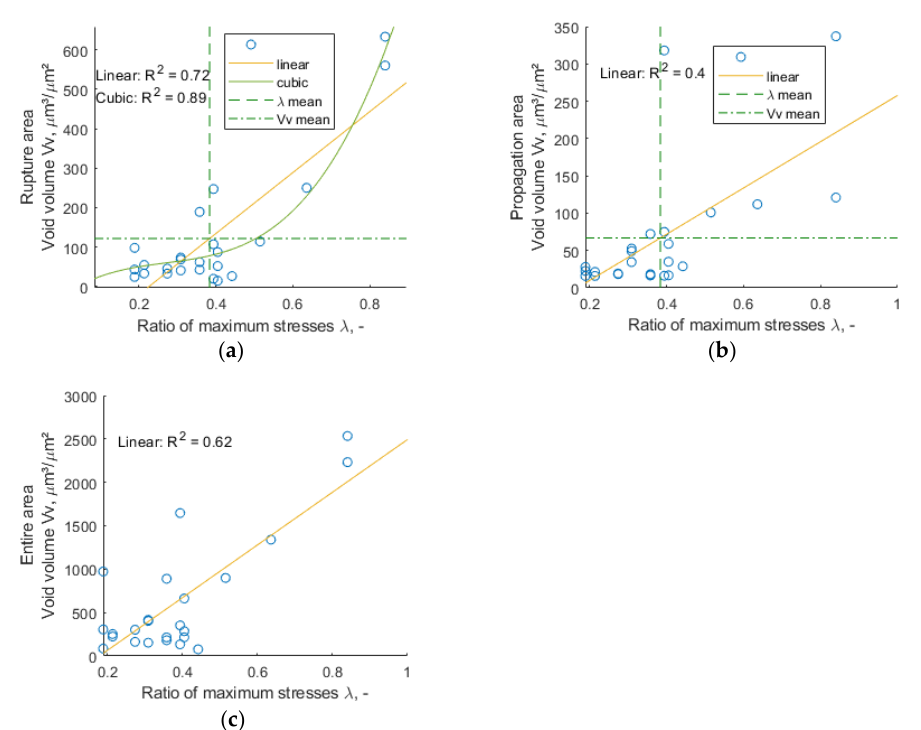
Figure 9. Void volume Vv evaluation at different applied ratios of maximum stresses λ for the investigated zones: ( a ) rupture area; ( b ) propagation area; ( c ) entire area.